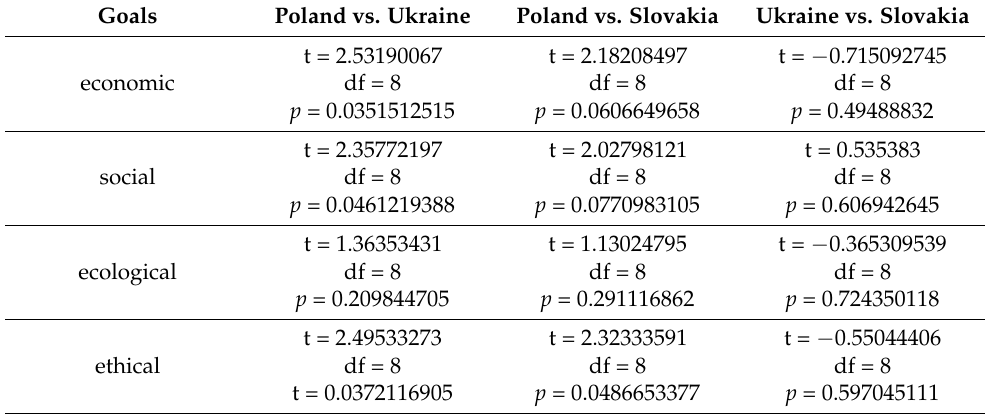
Table 9. Student’s t-scores for independent samples for relationships between economic, social, environmental and ethical goals indicated by respondents from Poland, Ukraine and Slovakia.